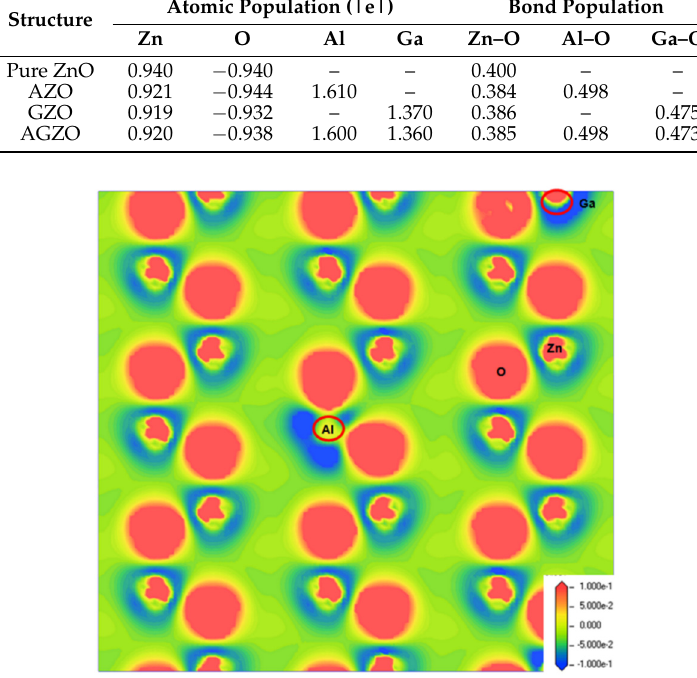
Figure 2. Distribution of charge density difference for the AGZO model.